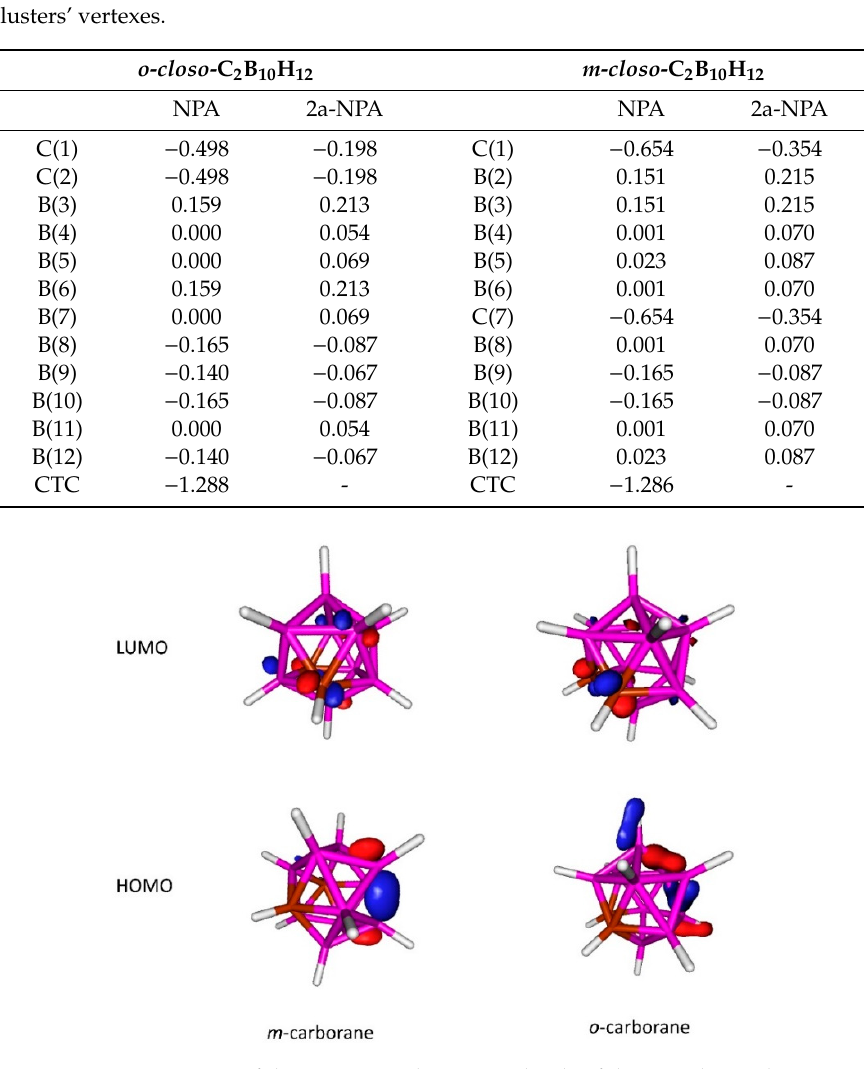
Figure 3. Comparison of the HOMO and LUMO orbitals of the o - and m -carborane.